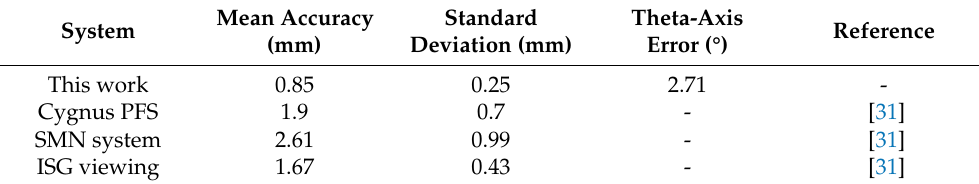
Table 2. Mean accuracy comparison with commercial frameless